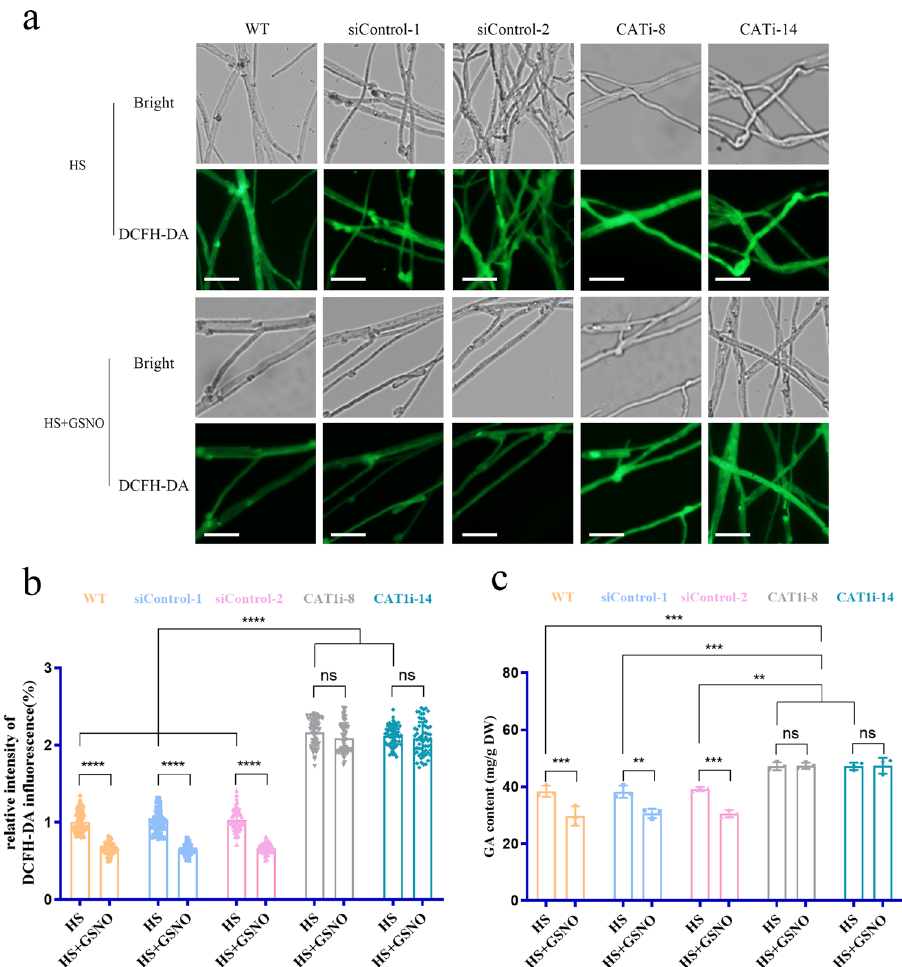
Fig. 4 ROS and GA content in the CAT-silenced strains treatment with GSNO under HS conditions. a Coverslips were placed on the bottom Petri dishes; after the WT and CAT-silenced strains cultured on mycelium grew onto the coverslips, the fungal mycelium was transferred onto a PDA plate with S-nitrosogluthionine (GSNO) for 30 min, then exposed to 42 °C for 20 min. ROS content was measured by staining with DCFH-DA in the WT and CAT- silenced strains untreated or treated with GSNO. Scale bar, 100 μ m. b ROS levels in the WT and CAT-silenced strains treated with GSNO. c The WT and CATi strains were grown for 5 days in PDA liquid cultures with shaking and then treated with 3-AT for 30 min. The strains were exposed to 42 °C for 12 h and shifted to 28 °C until the 7th day in stationary. The GA content in the CAT-silenced strains was untreated or treated with GSNO in the heat-stressed strains. Data are presented as the mean ± SD of data from three independent experiments (** P < 0.01, *** P < 0.001; **** P < 0.0001 by two-way ANOVA).